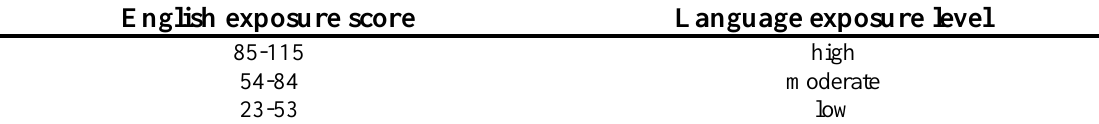
Table 1. Distribution of Scores Based on Language Exposure Level